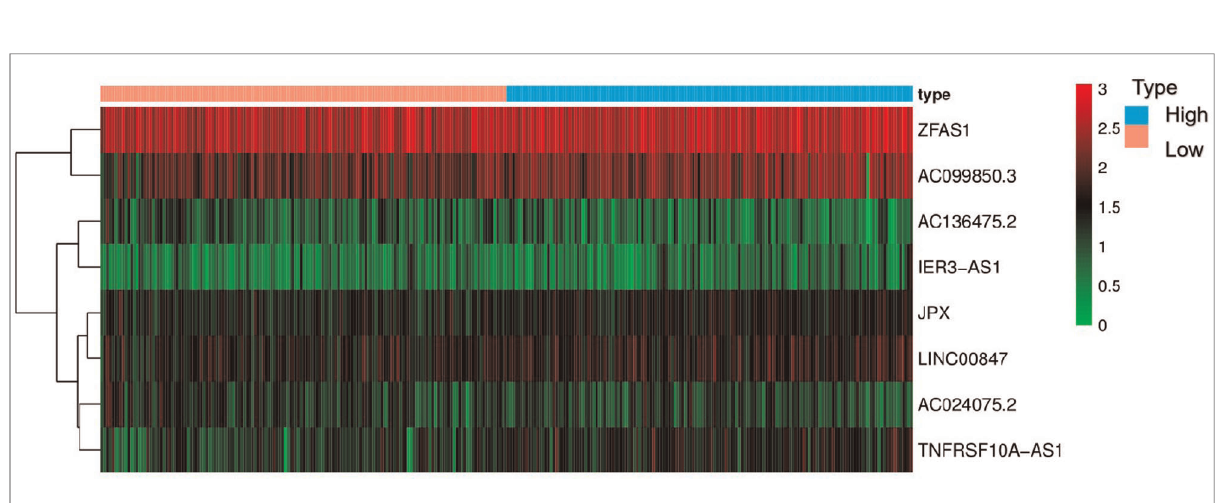
FIGURE 5 Heat map of the eight pyroptosis-related lncRNA. The expression levels of ZJPX, ZFAS1, TNFRSF10A-AS1, LINC00847, AC099850.3 and IER3-AS1 in high-risk patients were higher than those in low-risk patients. The expression levels of AC136475.2 and AC024075.2 in high-risk patients were lower than those in low-risk